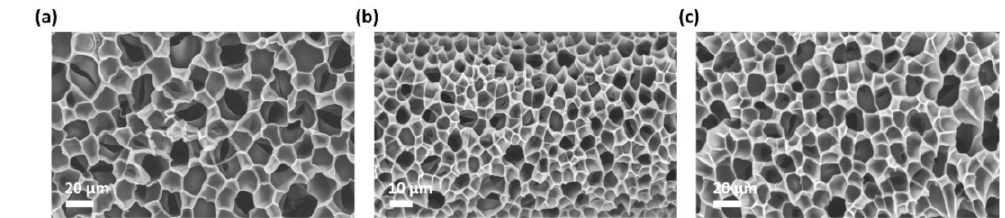
Figure 4. SEM images of pure PAA ( a ), MLGP/PAA ( b ), and MLGP/ Ag 0 /PAA ( c ) hydrogels.